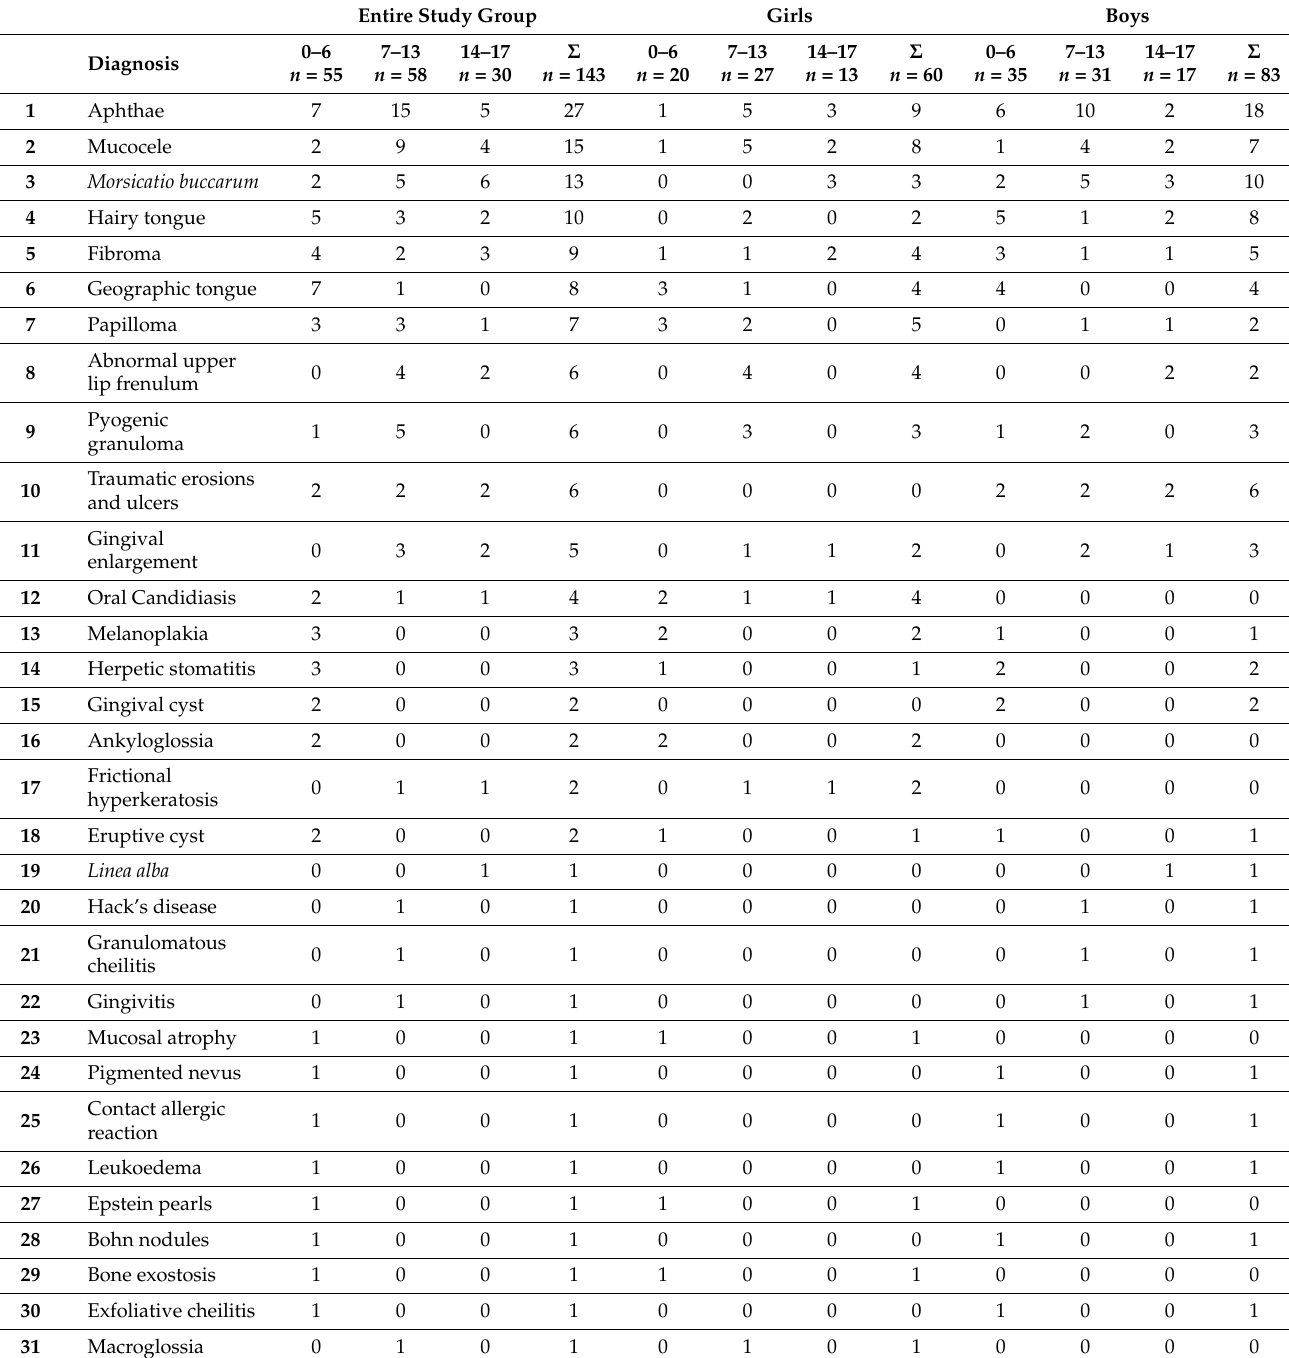
Table 2. All of the diagnosed oral mucosa